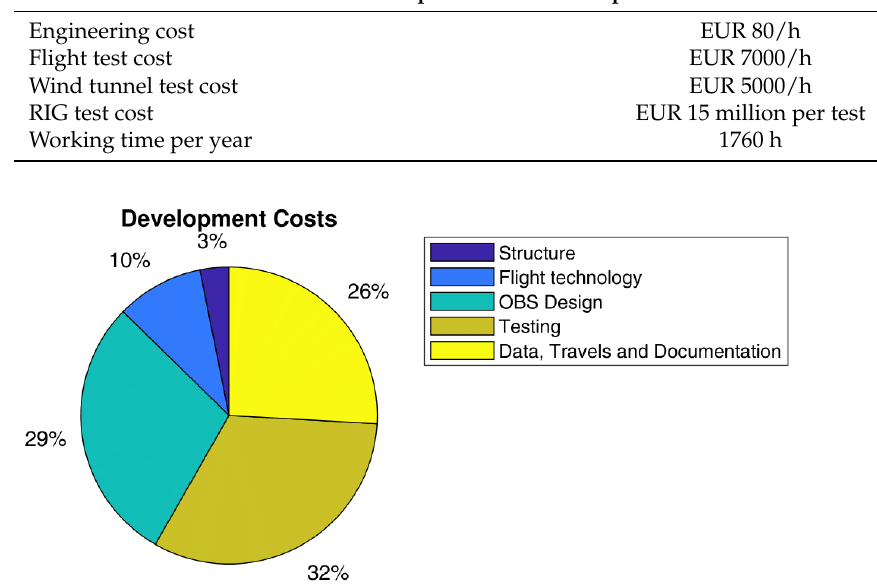
Figure 3. Development costs breakdown. Table 5. List of the development activities and their related efforts (in terms of the number of people, time and costs) required to perform the aircraft retrofit.